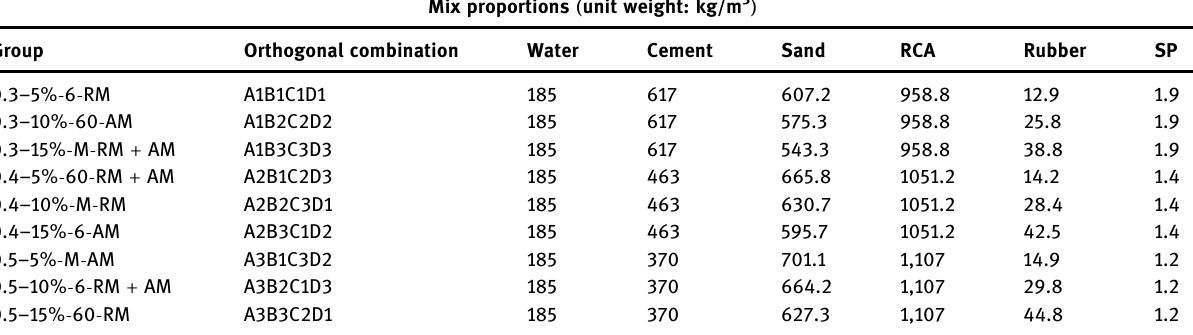
Table 8: Mix proportions of RRAC used in the experiment